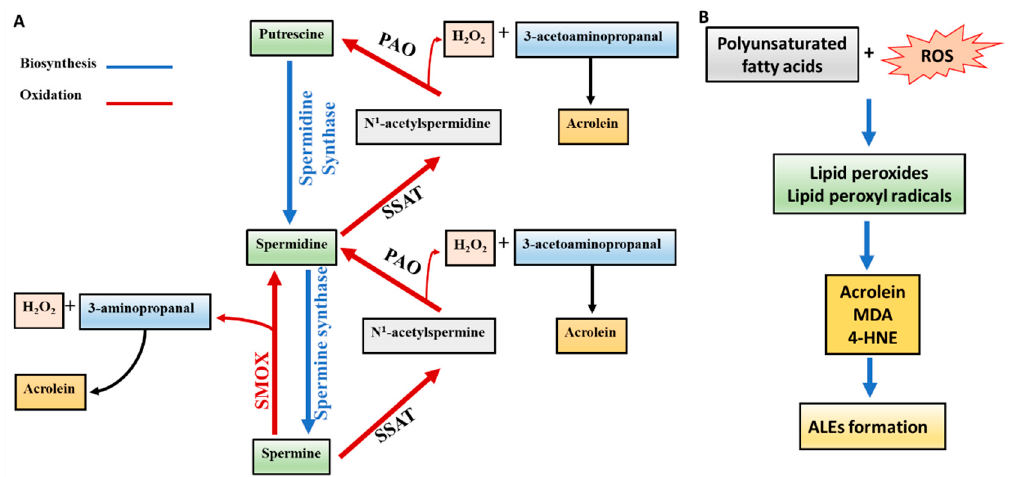
Figure 1. Diagrammatic representation of acrolein formation through polyamine oxidation pathway ( A ) and lipid peroxidation pathway ( B ). PAO: polyamine oxidase; SMOX: spermine oxidase; SSAT: spermidine/spermine N1-acetyltransferase; ALEs: advanced lipid peroxidation end products; MDA: malondialdehyde; ROS: reactive oxygen species; 4-HNE: 4-Hydroxynonenal.